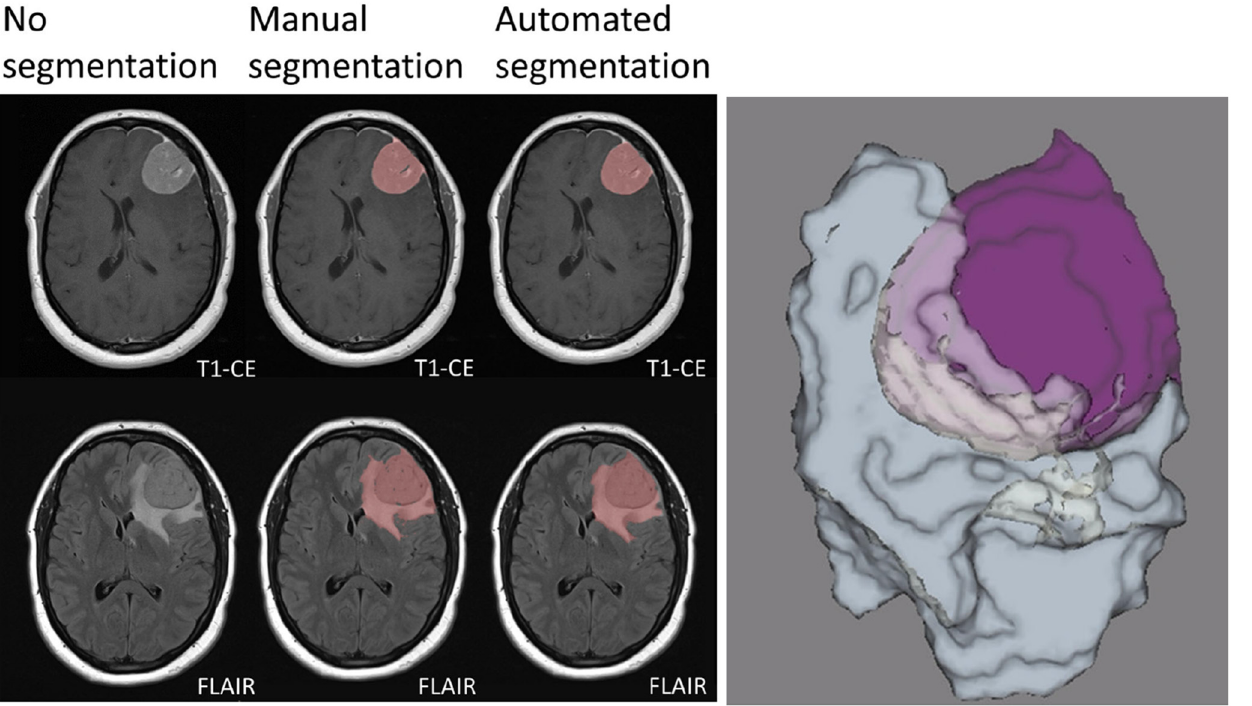
Figure 1. Manual and automated segmentation comparison in a meningioma of the left frontal convexity. The sharply demarcated lesion demonstrates intense contrast enhancement. Vasogenic edema of the surrounding white matter is also evident. Manual and automated segmentation are correctly matched. Three-dimensional rendering of the segmented tumor and edema volumes is also presented. T1-CE: contrast-enhanced T1-weighted imaging; FLAIR: fluid attenuated inversion recovery. Adapted from Ref. [13], under the terms of the Creative Commons Attribution-NonCommercial 4.0 License.